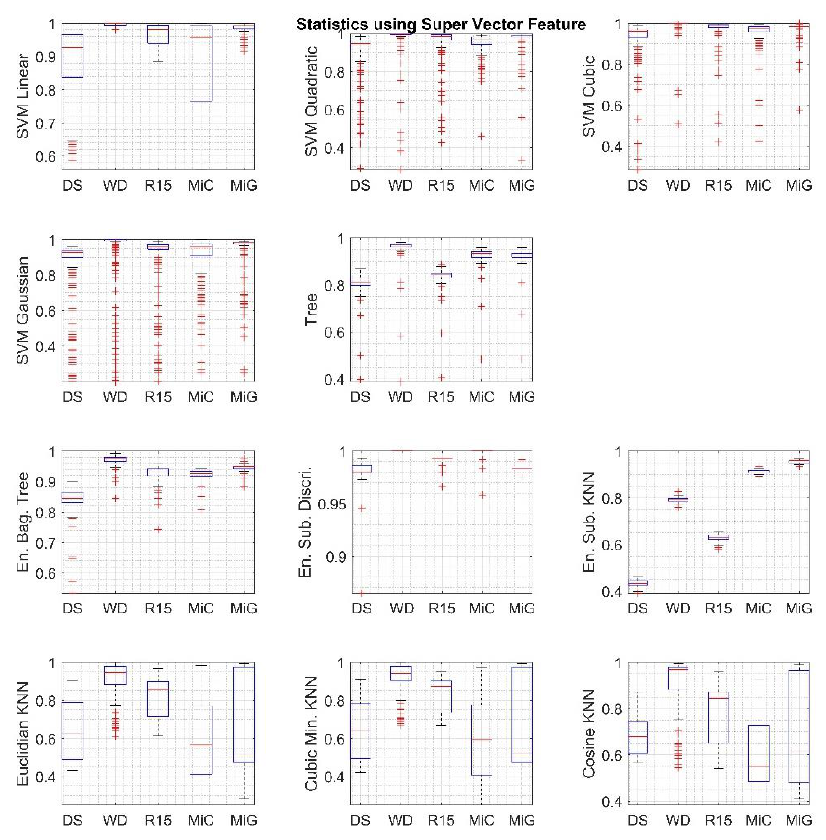
Figure 6. Boxplots calculated over the gathered classification results using the Super Vector feature set. Each column in the figures corresponds to a different sensor.